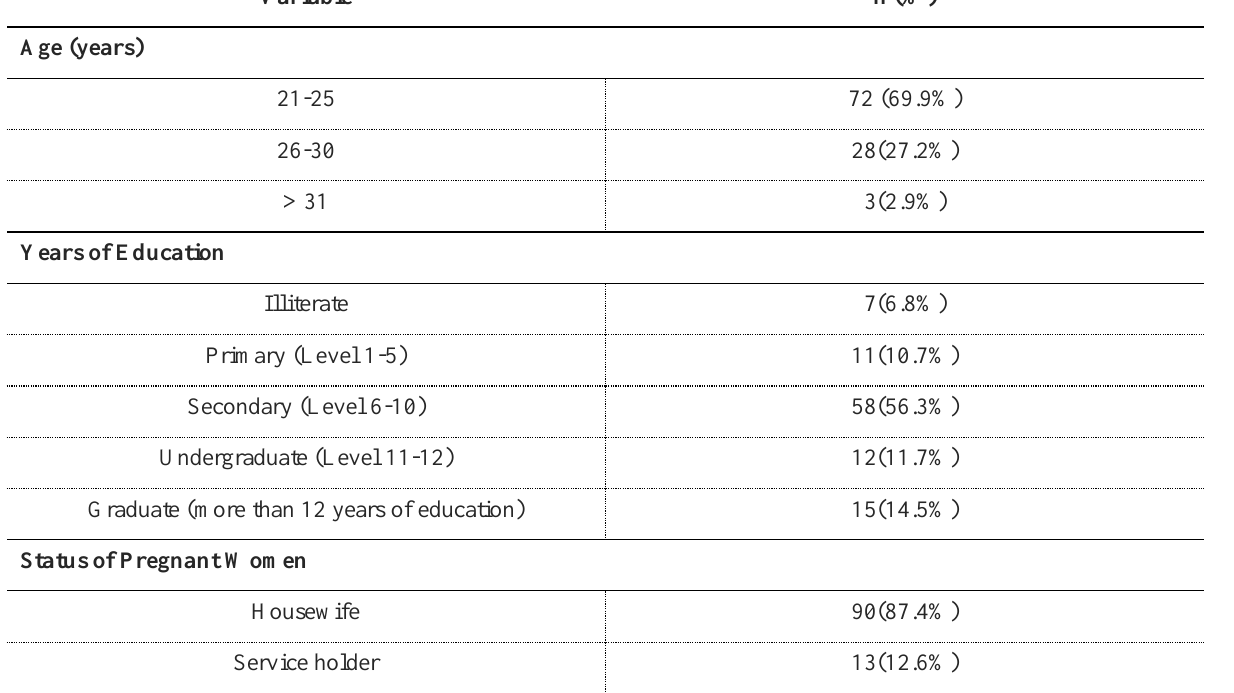
Table 1: Characteristics of pregnant women